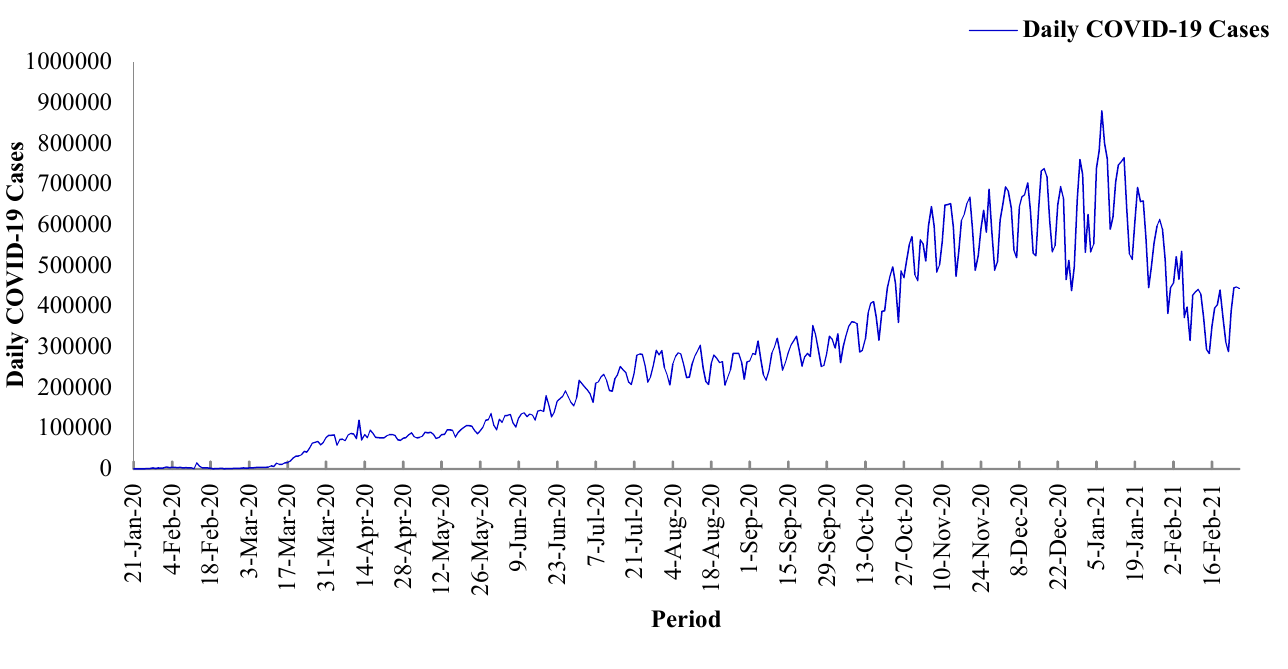
Figure 1. Daily movements of the COVID-19 cases.